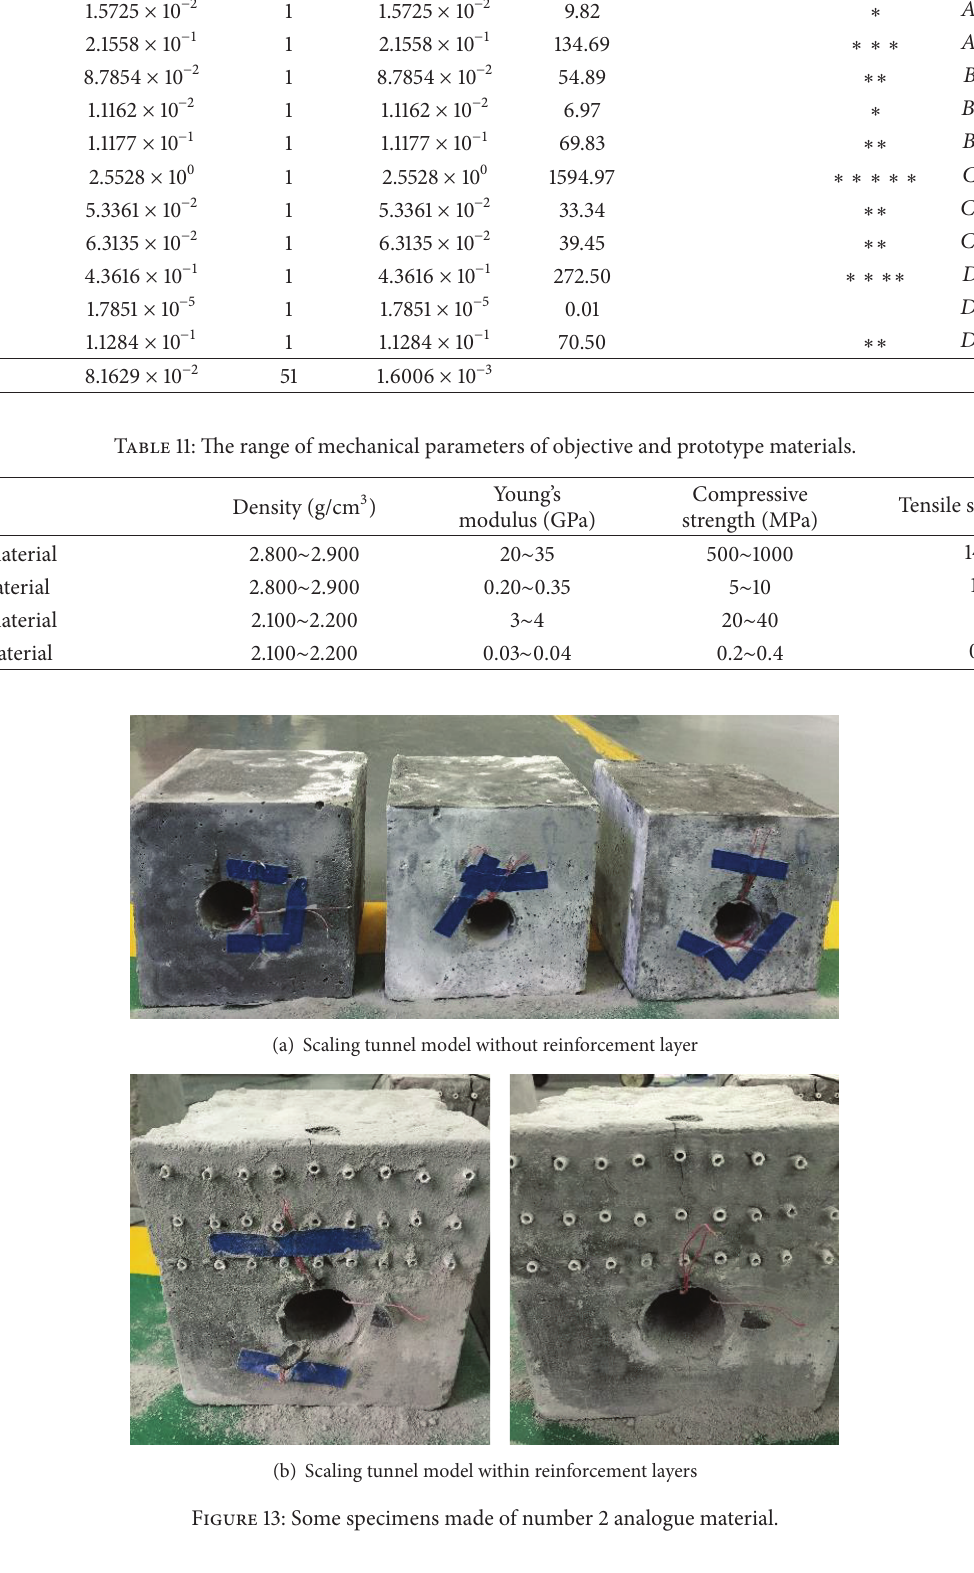
Figure 13: Some specimens made of number 2 analogue